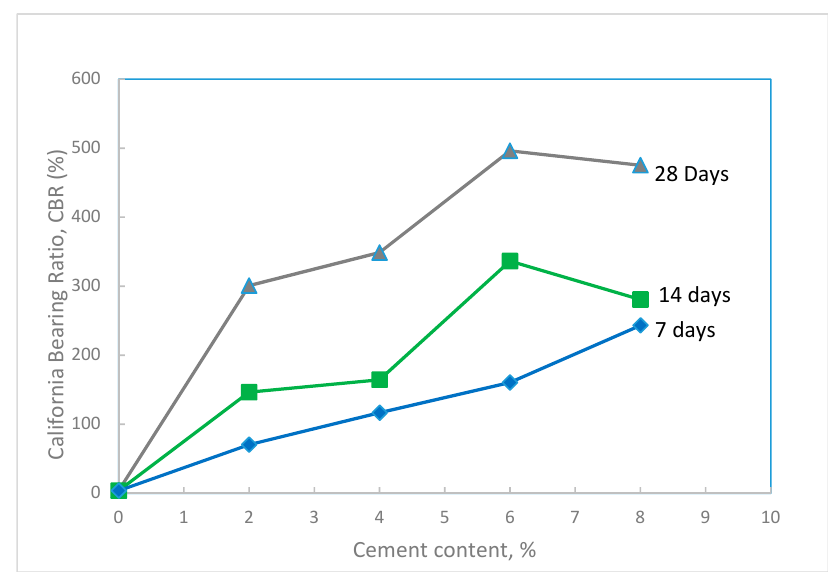
Figure 13. Variation of the CBR value of the treated waste sand with cement content for different curing times.